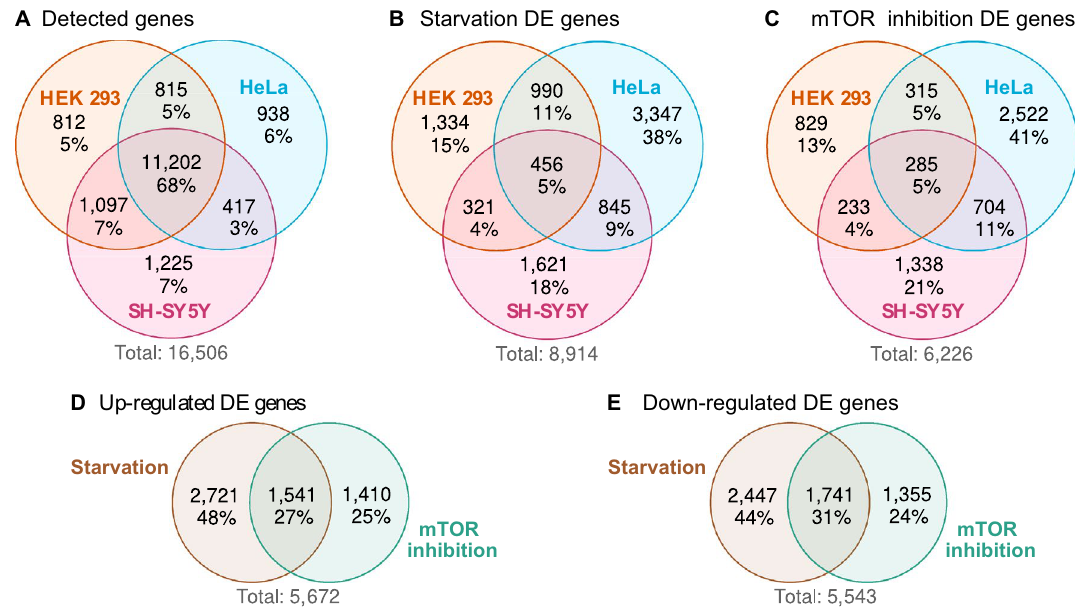
Figure 1. Overview of differentially expressed (DE) genes. ( A ) Genes were considered detectable if there were > 1.5 counts per million in > 3 samples out of all samples from the same cell line. ( B ) Genes that were DE between starved and control samples in at least one cell line. ( C ) Genes that were DE between mTOR inhibited and control samples in at least one cell line. ( D ) We collected DE genes associated with starvation or mTOR inhibition that were up-regulated in at least one cell line (inconsistent DE genes that were significantly up-regulated in one cell line but significantly down-regulated in another were excluded). ( E ) Down-regulated DE genes associated with starvation or mTOR